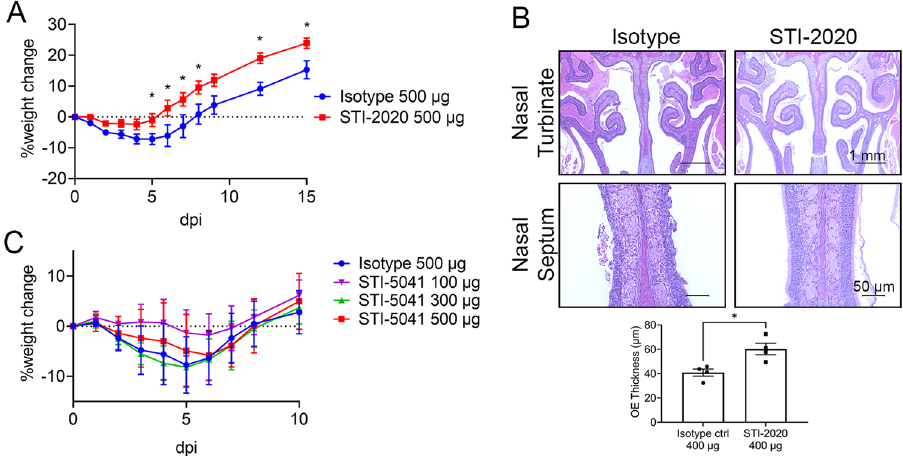
Figure 4. Efficacy of Intranasal (IN) Delivery of Neutralizing Antibodies in the golden (Syrian) Hamster Model of COVID-19. ( A , B ) Female hamsters were inoculated with SARS-CoV-2 USA/WA-1/2020, and then administrated with 500 µg or 400 µg Isotype control antibody or 500 µg or 400 µg STI-2020 intranasally at 12 h post-infection. ( A ) Average % weight change ± SEM was plotted for each group. Days in which there was a significant difference in average % weight change for STI-5020 at 500 µg compared to Isotype control IgG 500 µg-treated animals are denoted by * ( p -value < 0.05). ( B ) Upper panels show representative figures of nasal turbinates and nasal septum at 5 d.p.i. Average ± SEM of OE thickness on the nasal septum in the lower graph for STI-5020 at 400 µg compared to Isotype control IgG 400 µg-treated animals are denoted with * ( p -value < 0.05). ( C ) Hamsters were inoculated with SARS-CoV-2 Beta variant, and then administrated with 500 µg Isotype control antibody or 100 µg, 300 µg, or 500 µg STI-5041 intranasally at 12 h post-infection. Average % weight change ± SEM was plotted for each